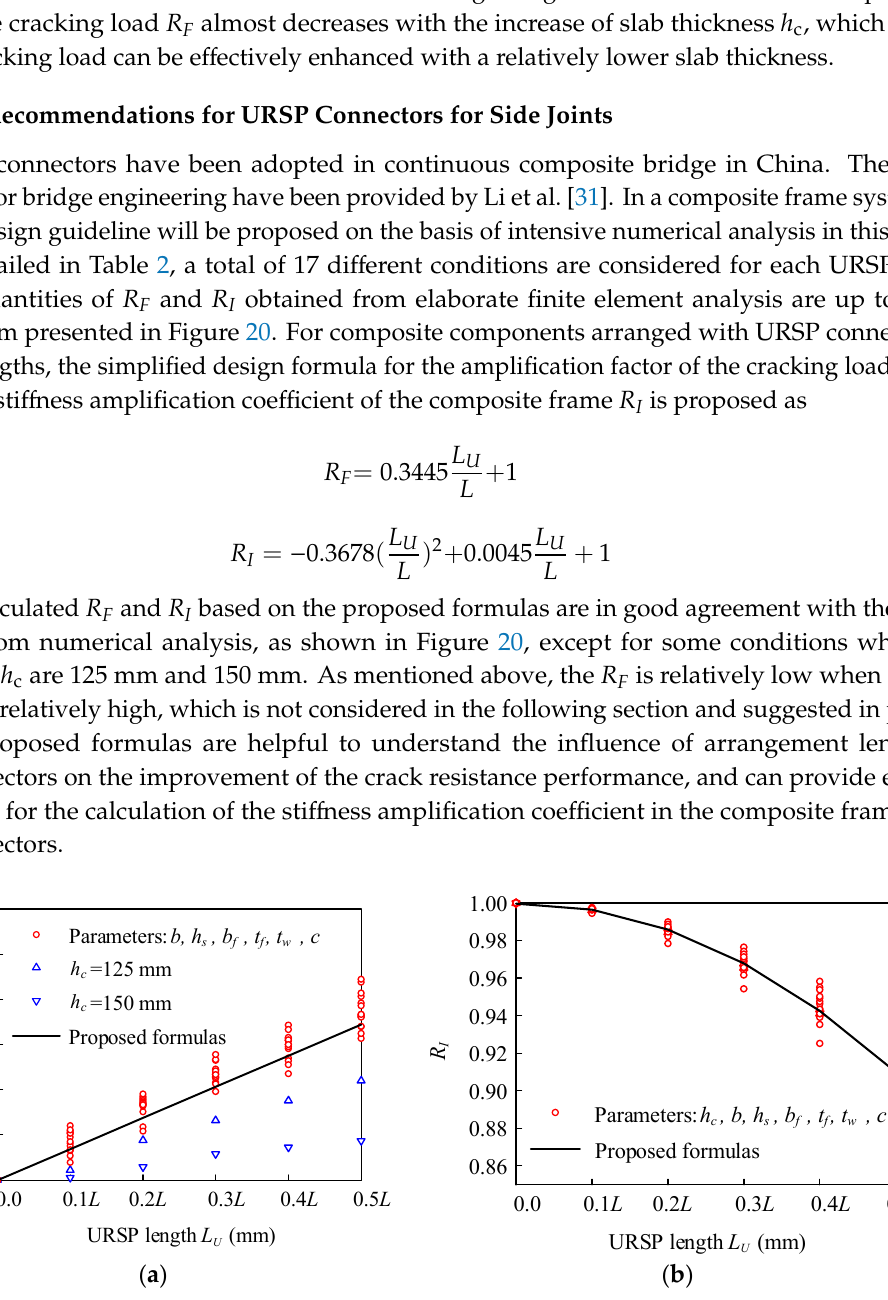
( b ) Figure 21. Two loading configurations of middle joints. ( a ) Load case 1; ( b ) Load case 2. For load case 1, the capacity of middle joints with URSP connectors distributed in 0.5 L is compared to that only arranged with stud connectors, and a limited difference can be observed in these two cases. As shown in Table 3, M Stud- L and M URSP-0.5 L represent the ultimate moment of middle joints with studs only and URSP connectors distributed in 0.5 L , respectively. The application of URSP connectors with the arrangement length of 0.5 L poses a limited influence on the capacity of the middle joints, which is similar to the research findings from the side joints discussed in Section 4.